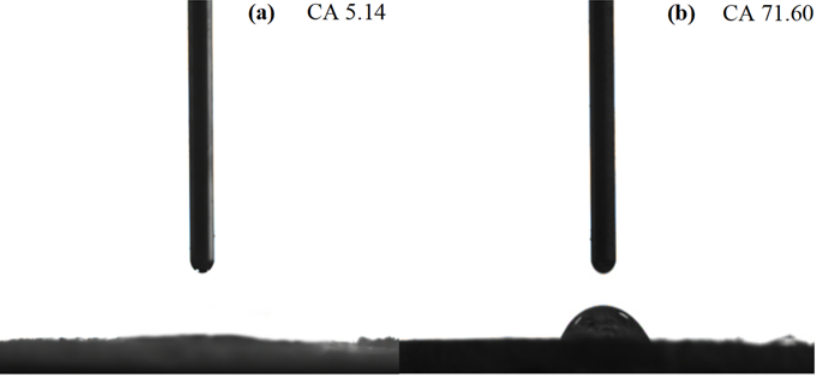
Figure 4. Contact angle of rice straw: ( a ) unmodified, ( b ) modified with SDS under the concentration of 2%, and reacting for 120 min at 20 °C.